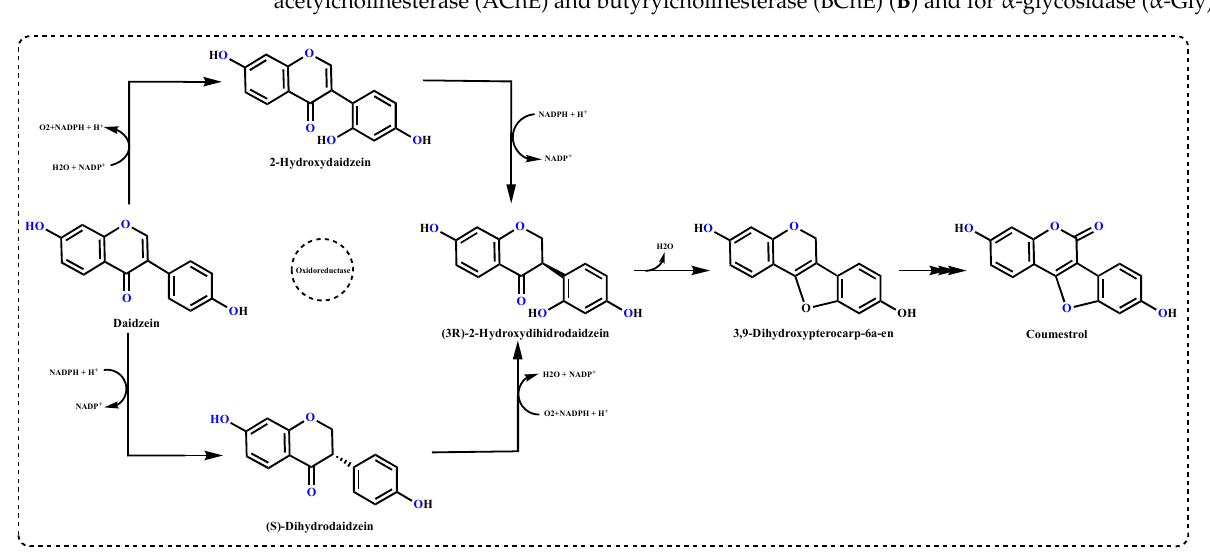
Figure 2. Biosynthesis pathway of Coumestrol from daidzein. Acetylcholinesterase (AChE) and butyrylcholinesterase (BChE) belong to the carboxylesterase enzyme class [29]. Both cholinergic enzymes hydrolyze the neurotransmitters acetylcholine (ACh) and butyrylcholine (BCh) to choline and acetate/butyrate, respectively. Also, AChE hydrolyzes several species of ChEs all over the human body, especially in blood serum, the pancreas, the liver, and the central nervous system (CNS) [30]. It is found in erythrocyte membranes, nerves, muscles, the CNS, motor and sensory fibers, peripheral tissues, and cholinergic and non ‐ cholinergic fibers. BChE is mainly associated with endothelial and glial cells in brain cells [31]. AChE inhibitors